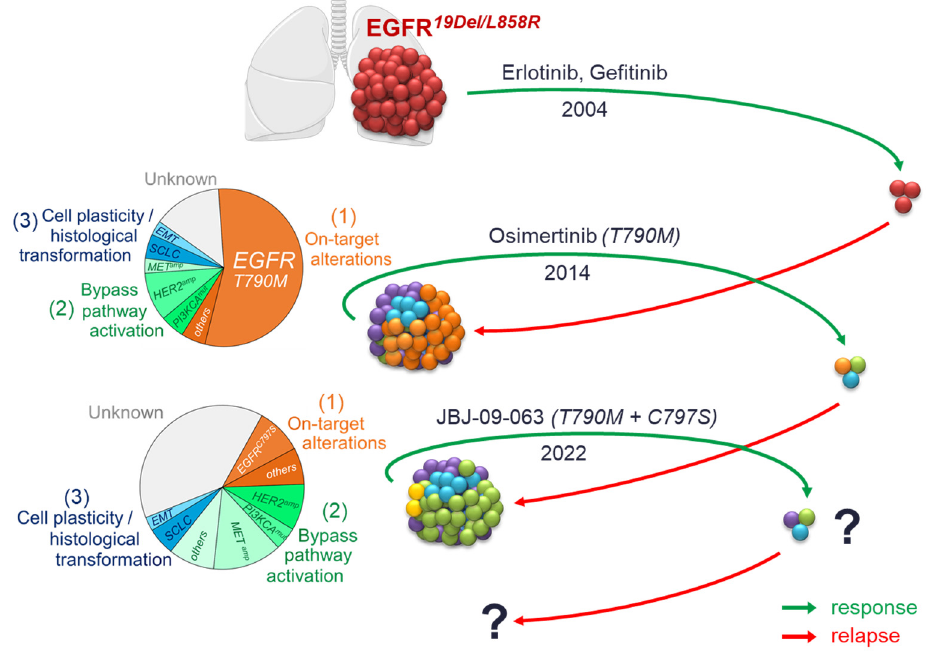
Figure 2. The vicious circle of resistances to EGFR-TKI in NSCLC. Although new targeted therapies are designed to counteract the resistance mechanisms developed with previous-generation EGFR- TKI, similar resistance inevitably emerges, resulting in little improvement to overall survival in pa-